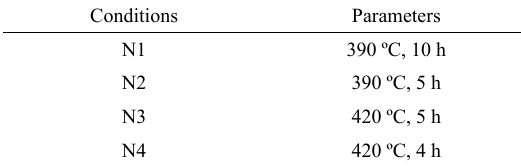
Table 1. Plasma nitriding